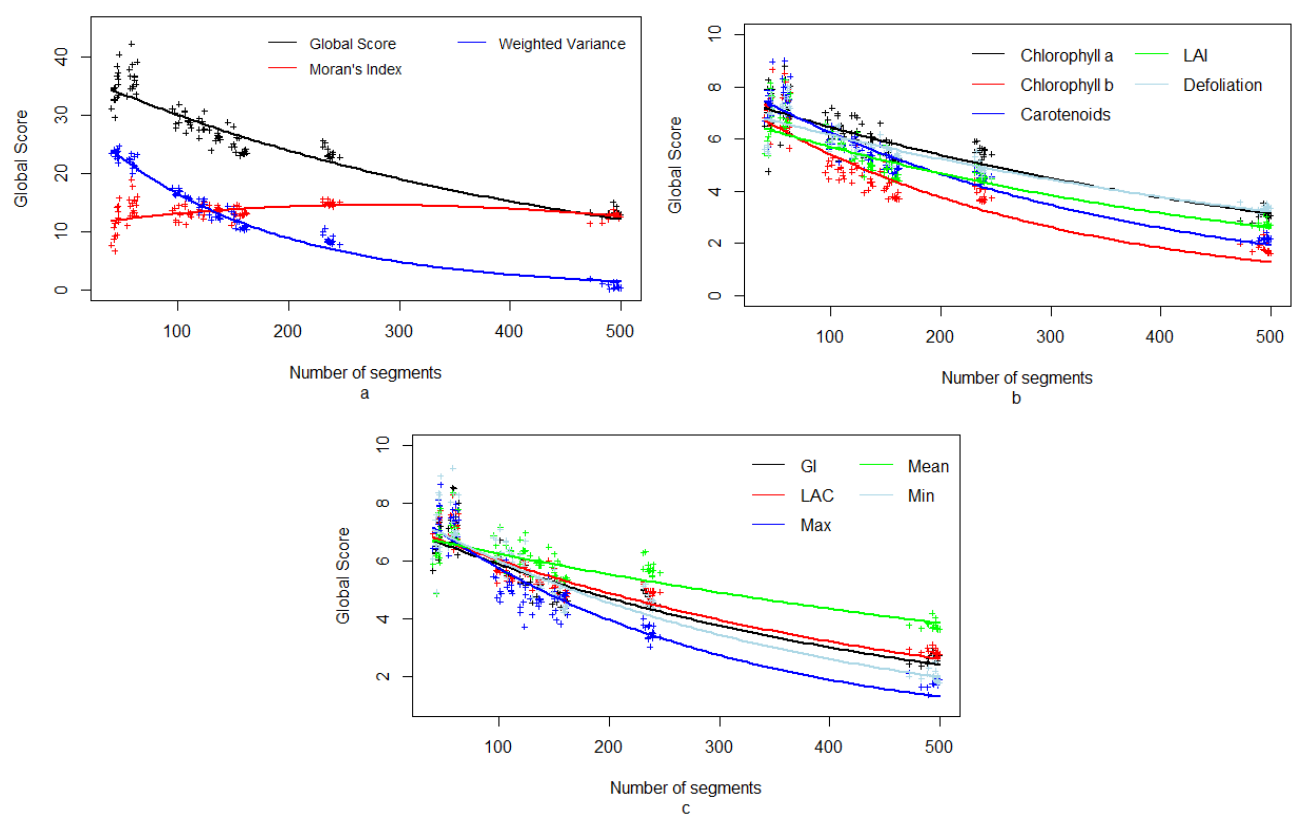
Figure 6. Behavior of the Global Score according to the number of segments for ( a ) Moran’s Index and Weighted Variance, ( b ) chlorophyll a, chlorophyll b, carotenes, LAI and defoliation, and ( c ) Gini index (GI), Lorenz asymmetry curve (LAC), maximum (Max), mean (Mean) and minimum (Min) index parameters in the segmentation process.